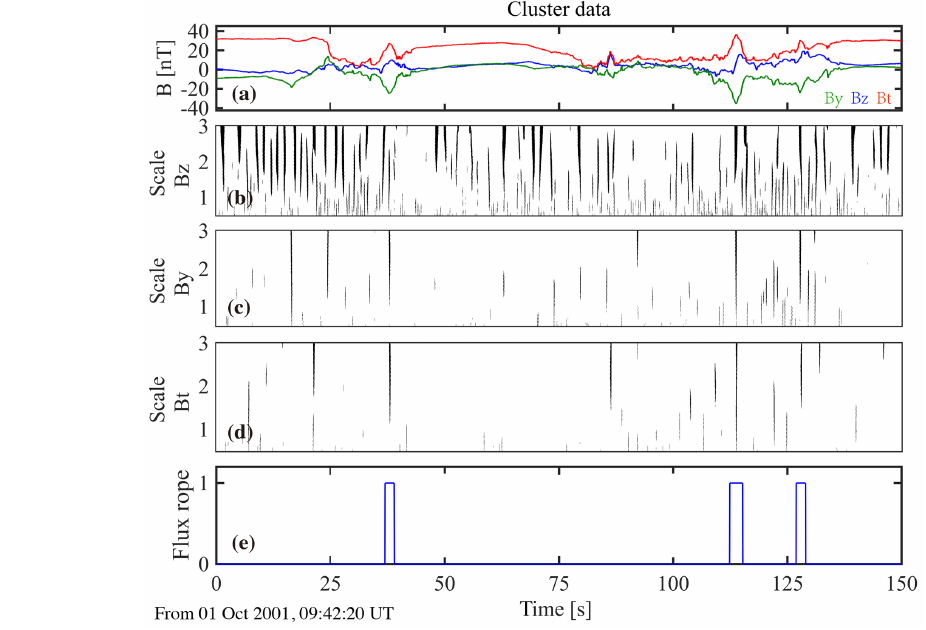
Figure 7. Testing the method on Cluster data in the magnetotail. The same format as in Fig. 6.